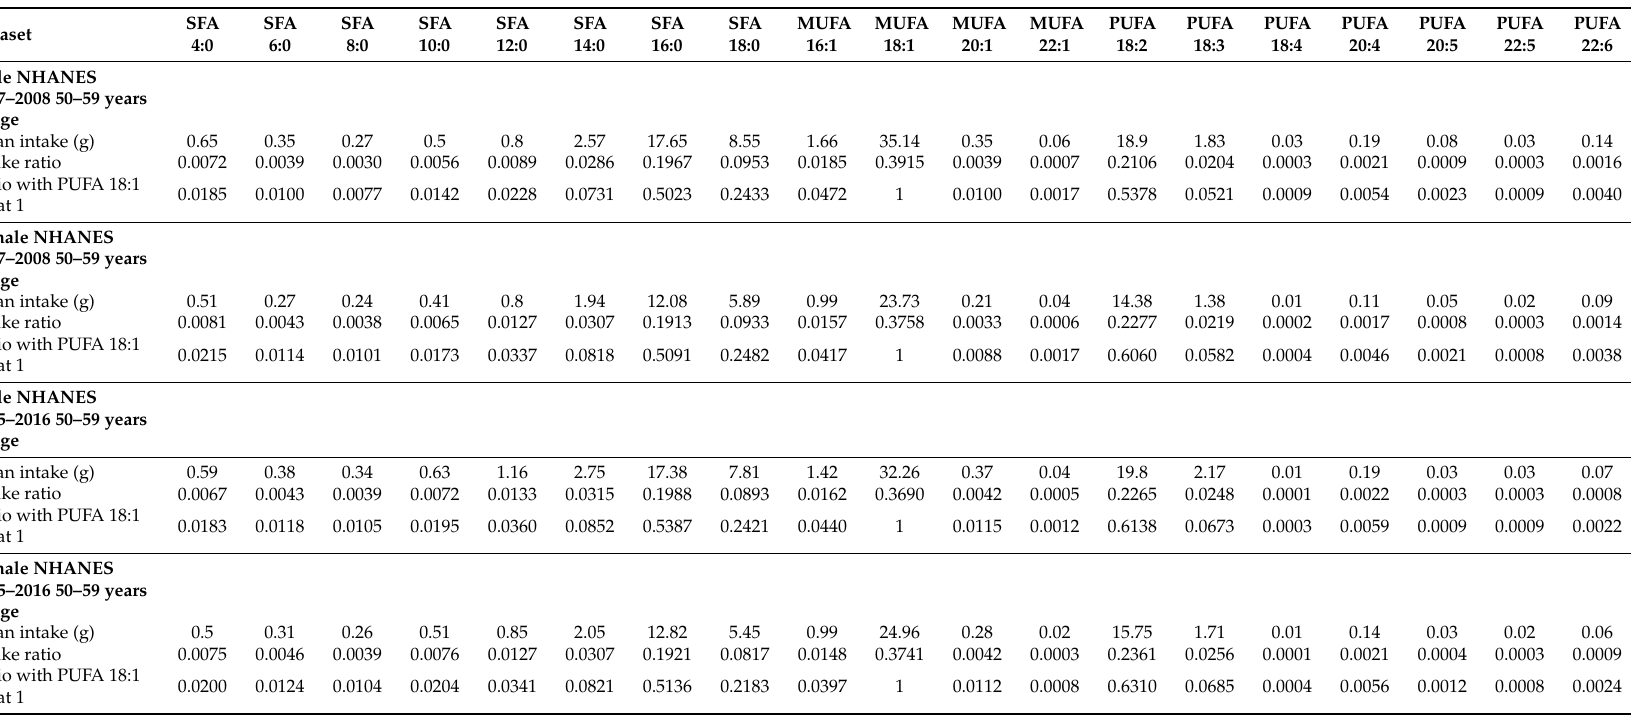
Table 3. Fatty acid intakes derived from the National Health and Nutrition Examination Survey (NHANES) 2007–2008 and 2015–2016 data, their ratios, and their concentrations relative to oleic acid (n-6/n-3 polyunsaturated fatty acid (PUFA) 18:1) for males and females 51–59 years of